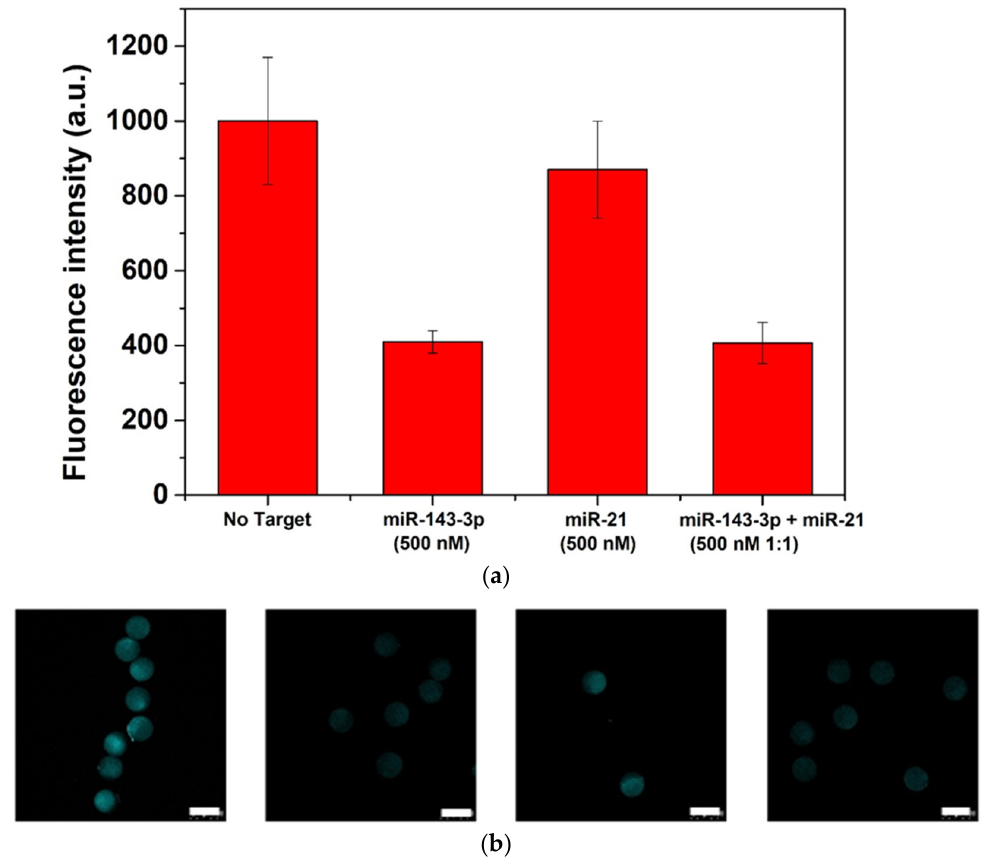
Figure 5. Assay specificity of 3D-hydrogel microparticles: recovery of fluorescence ( a ) and corre- sponding confocal images ( b ) (scalebar corresponds to 100 μ m).